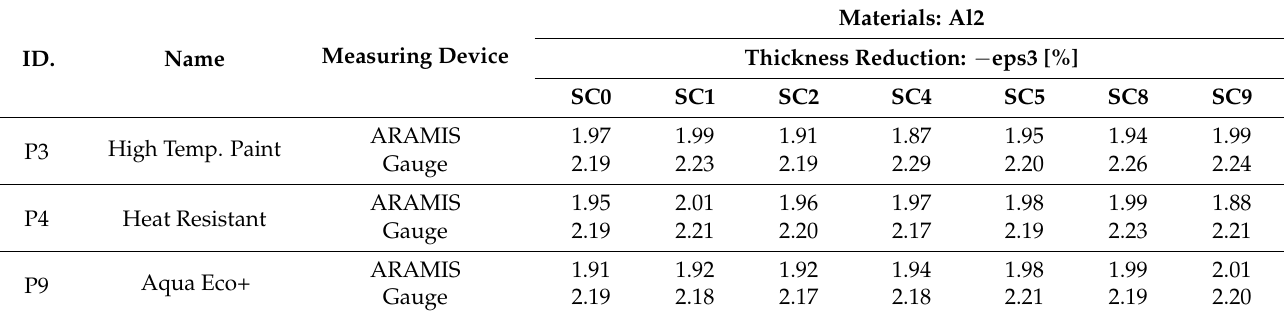
Table 12. Measurement results of usability